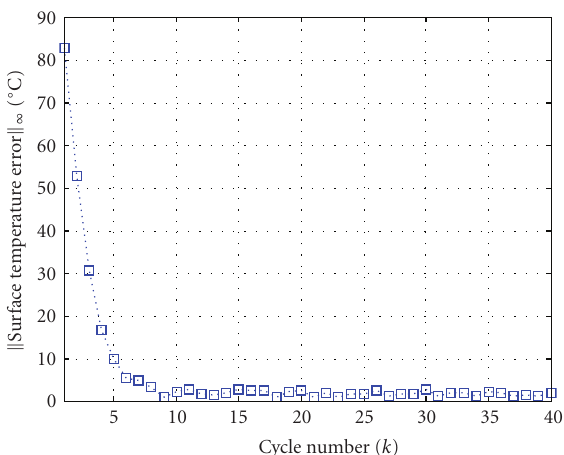
Figure 4: Error on terminal surface temperature (1st simulation).